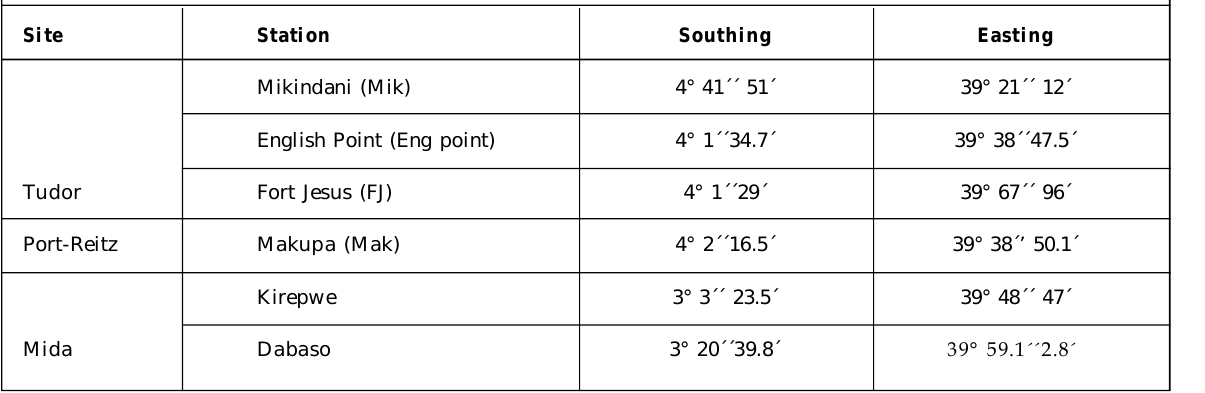
Table 1: Sites, stations and GPS coordinates